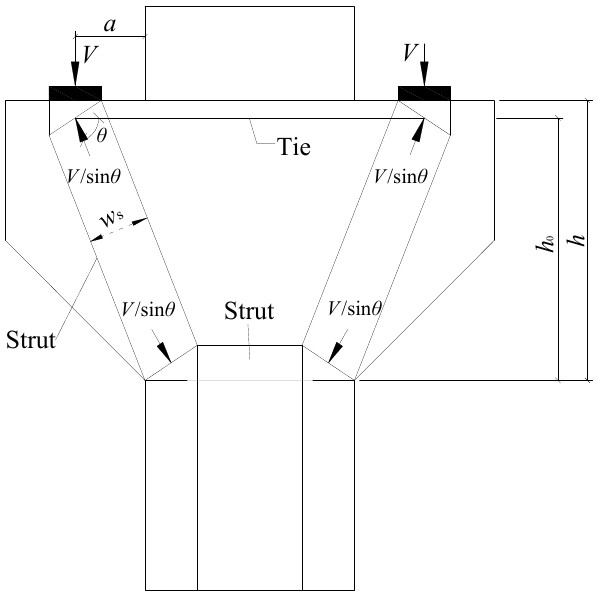
Figure 14. Simpli fi ed strut-and-tie model of a corbel. Figure 14. Simplified strut-and-tie model of a